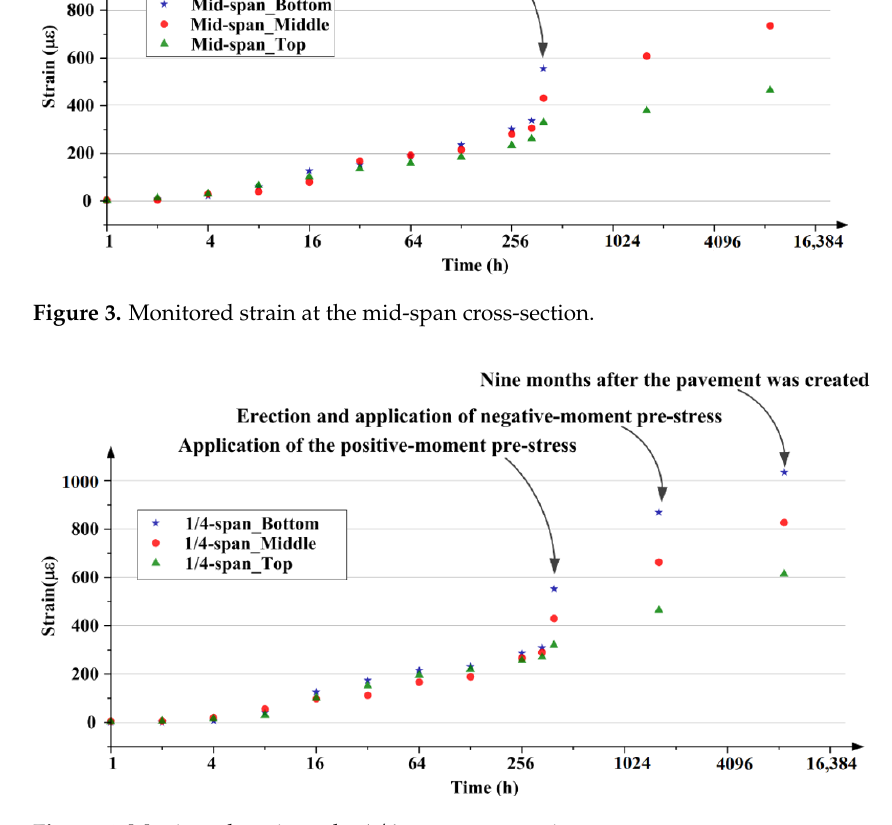
Figure 4. Monitored strain at the 1/4 span cross-section.